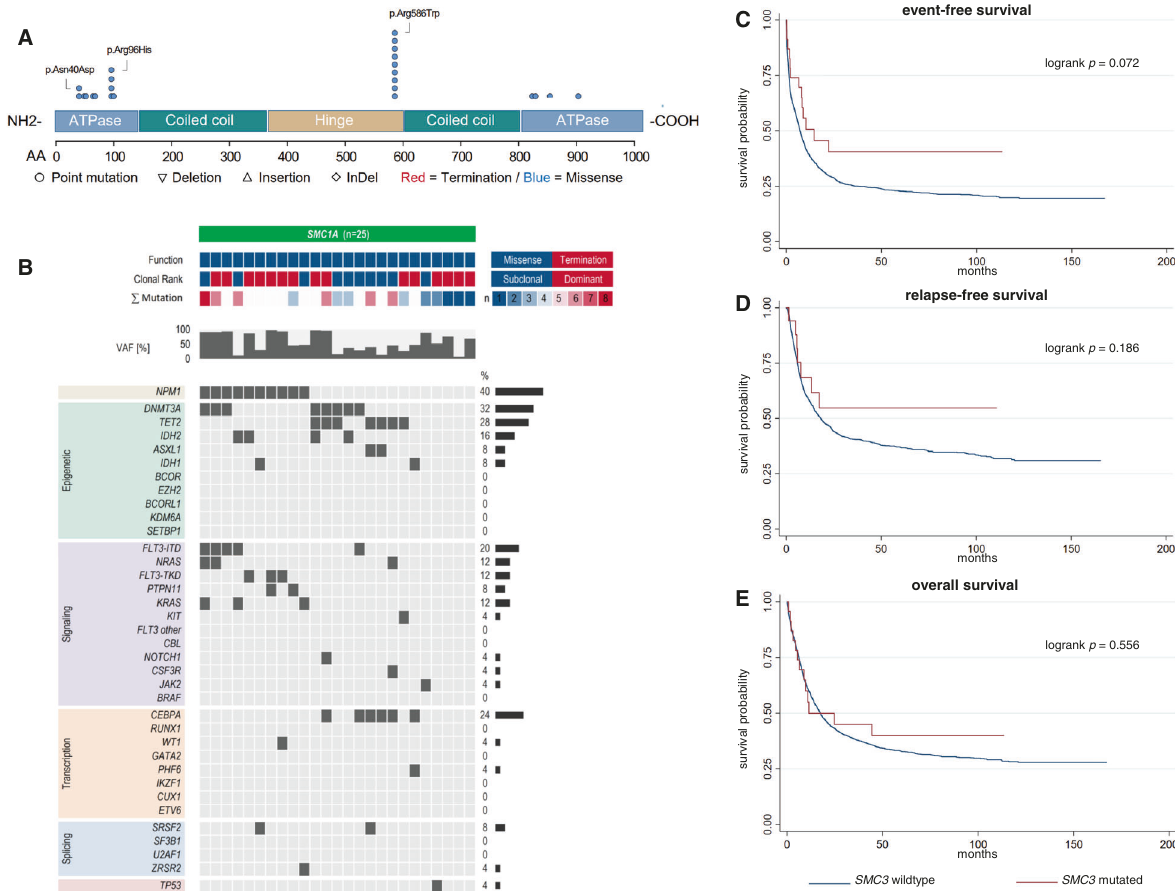
Fig. 3 Distribution, co-mutational spectrum and survival analysis for AML with mutated SMC1A . Graphic representation of the domain structure of SMC1A and positions of SMC1A mutations in 25 AML patients ( A ). Mutations of SMC1A are categorized by function (missense = blue, termination = red), clonal rank (dominant = red/subclonal = blue), number of mutations, and variant allele fraction, and associated co-mutations ( B ). For detailed information on co-mutations and results of individual signi fi cance tests, see Tab. S13. Survival analysis using the Kaplan-Meier method and logrank test for event-free ( C ), relapse-free ( D ) and overall survival ( E ) differentiating between SMC1A -mutated and SMC1A -wildtype